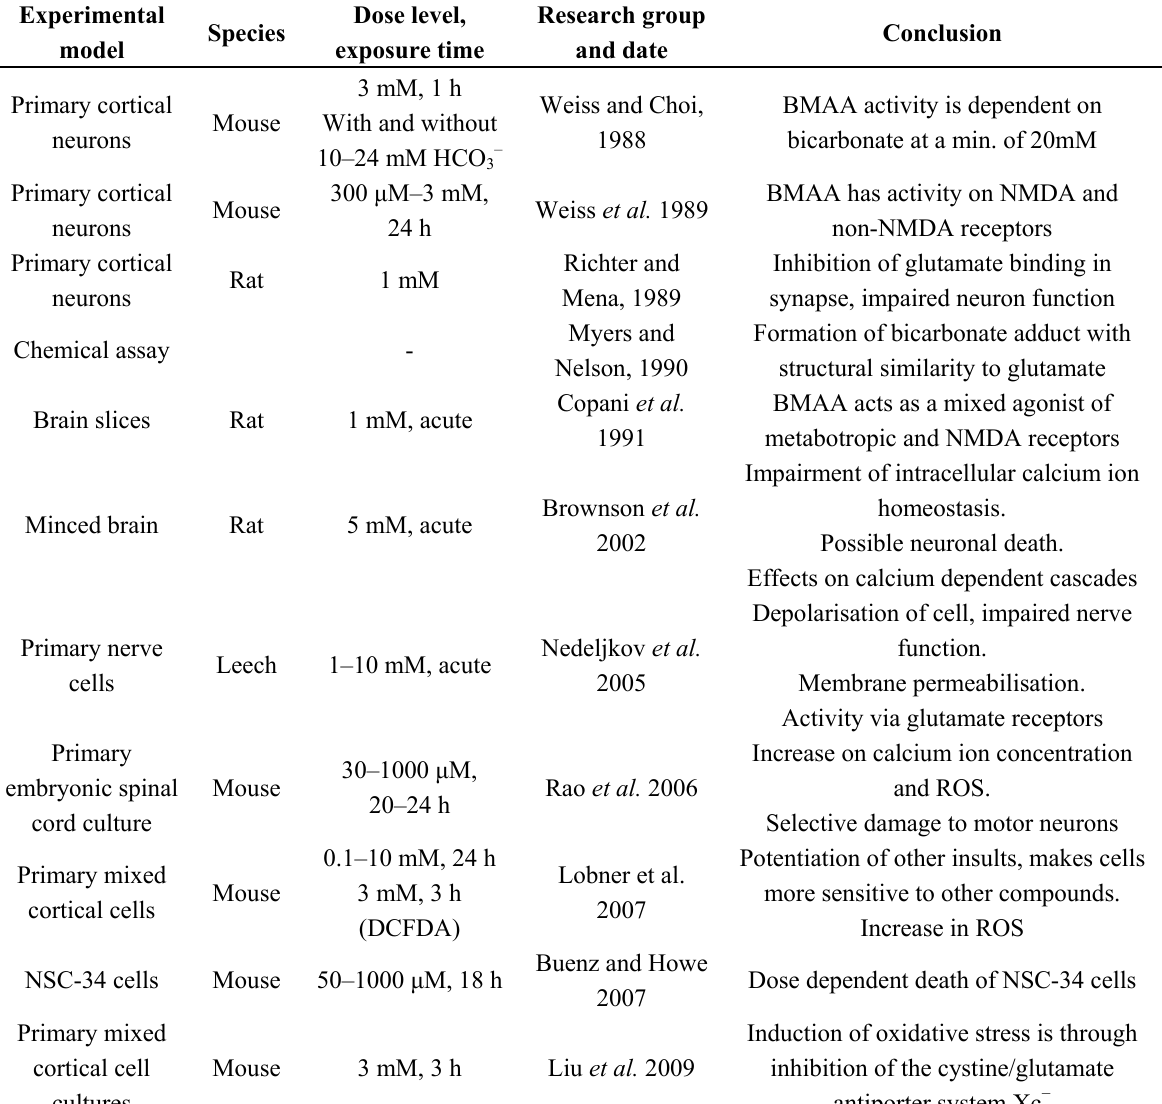
Table 2. A chronological summary of mechanisms of BMAA activity determined by in vitro